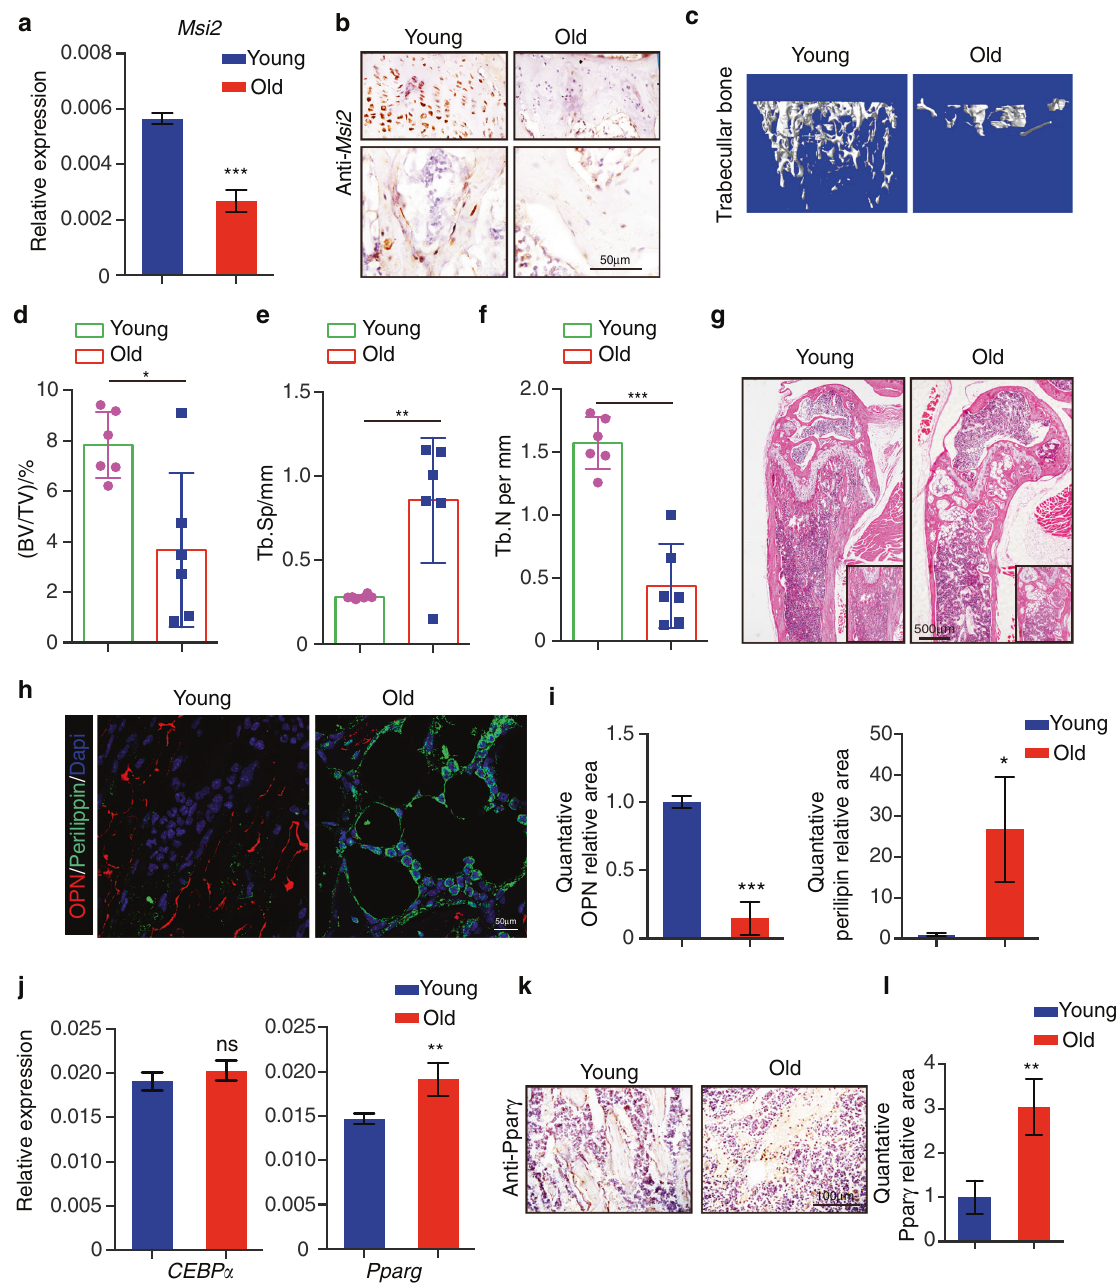
Fig. 7 Msi2 expression is downregulated during aging. a qPCR results of Msi2 expression in BMSCs from 8-week-old and 24-month-old mice ( n = 4). Data represent the mean ± SD, *** P < 0.001, unpaired Student ’ s t test. b Immunohistochemistry staining of Msi2 from 8-week-old and 24-month-old mice. Scale bar = 50 μ m. c Three-dimensional μ -CT images of trabecular bone of distal femurs isolated from 8-week-old female and 24-month-old female mice ( n = 6). d μ -CT analysis of trabecular bone volume per tissue volume (BV/TV) in the distal femur of 8-week-old female and 24-month-old female mice. e μ -CT analysis of the distal femur of 8-week-old female and 24-month-old female mice for trabecular separation (Tb.Sp). f μ -CT analysis of the trabecular number (Tb.N) of the distal femur of 8-week-old female and 24-month-old female mice. g Hematoxylin-eosin staining of femurs from wild-type mice at 8 weeks and 24 months. Scale bar = 500 μ m. h Immunostaining of perilipin A/B (green) and OPN (red) of femurs from 8-week-old and 24-month-old mice. Scale bar = 50 μ m. i Quanti fi cation of the relative areas of OPN and Perilipin in ( h ). j qPCR results of Cebp α and Ppar γ expression in BMSCs from 8-week-old and 24-month-old mice ( n = 4). Data represent the mean ± SD, *** P < 0.01, ns: no signi fi cance, unpaired Student t test. k Immunohistochemistry staining of PPAR γ from 8-week-old and 24-month-old mice. Scale bar = 100 μ m. l Quanti fi cation of the relative area of PPAR γ in ( k